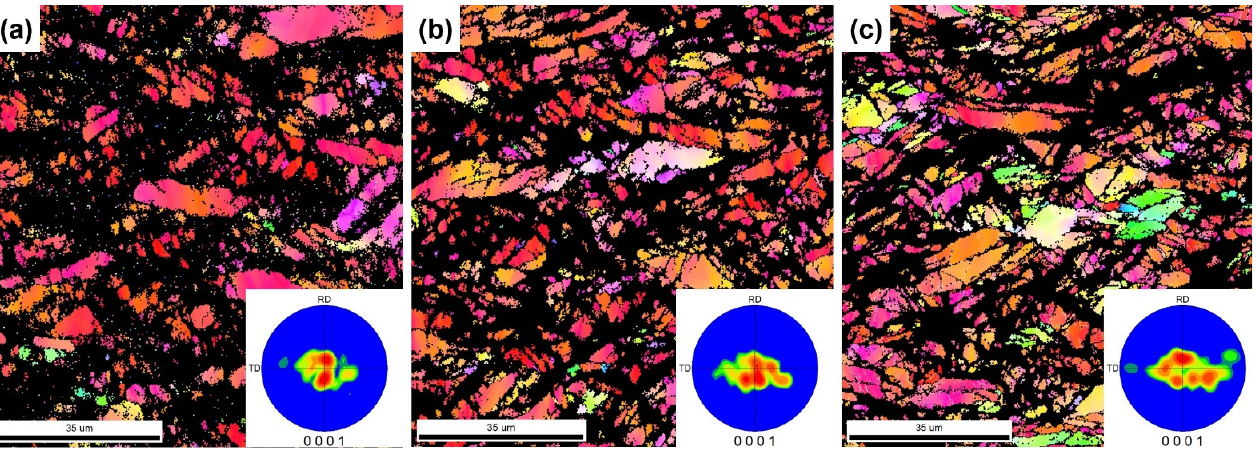
Figure 2. EBSD-IPF maps and pole figures for basal planes of the cold-rolled sheets of ( a ) AZXW3100, ( b ) AZXW2100, and ( c ) AZXW1100. The fraction of shear bands (black region) is 52.9%, 48.2%, and 42.5%, respectively.